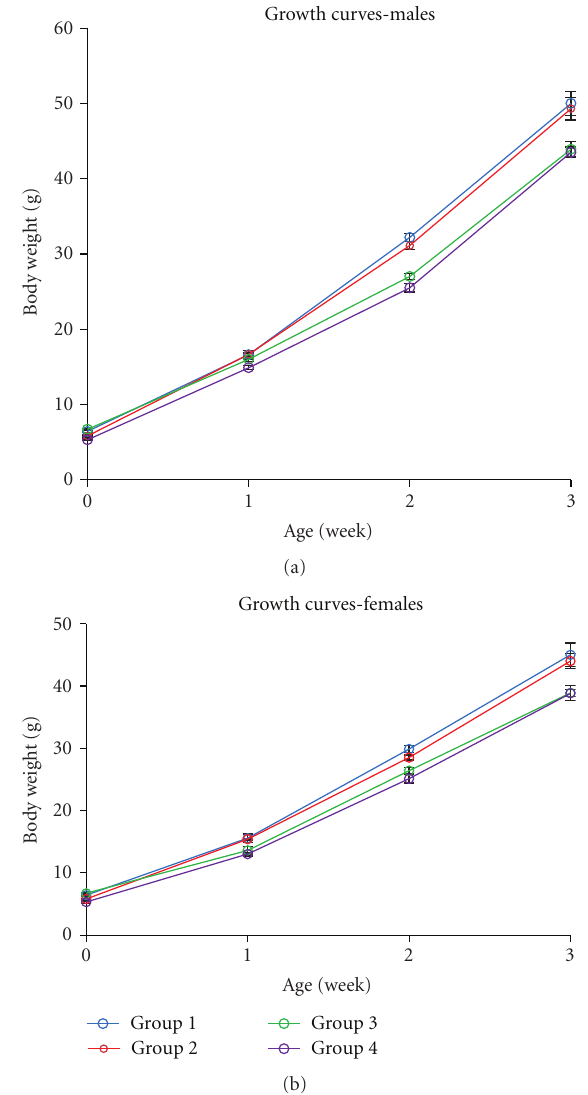
Figure 6: The growth curves for the male (a) and female (b) pups of the control group and the three groups exposed to elevated temperature from birth until weaning. Data represent the mean ±